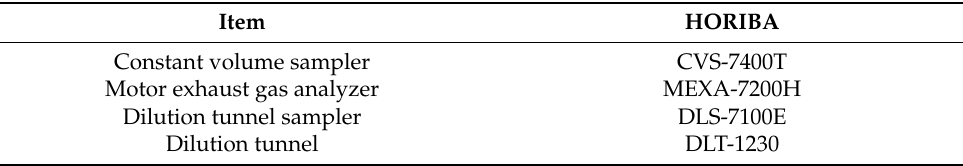
Table 2. Specifications of exhaust emission analyzer.